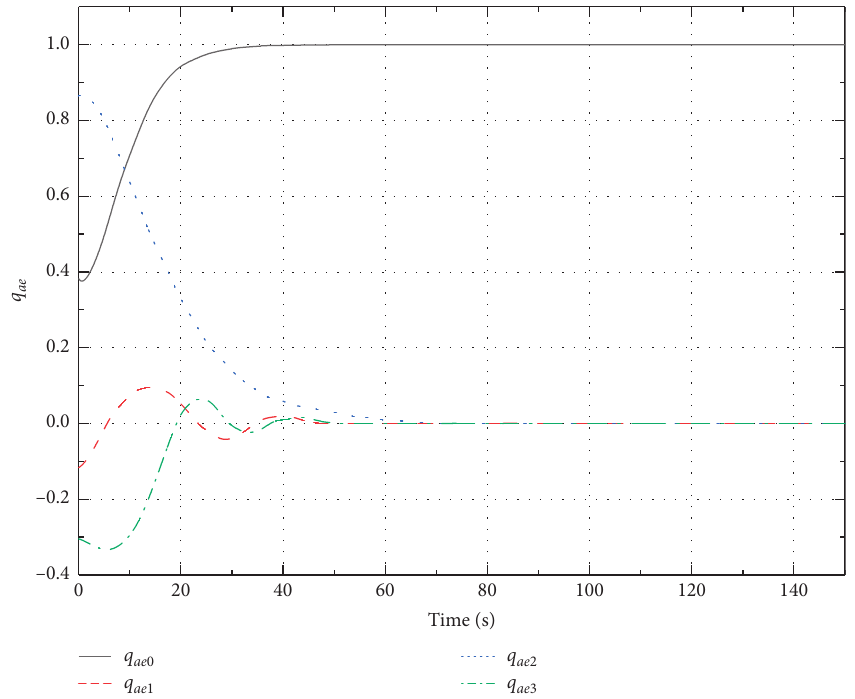
Figure 4: Trajectories of vector component of the error quaternion of flexible solar panel.